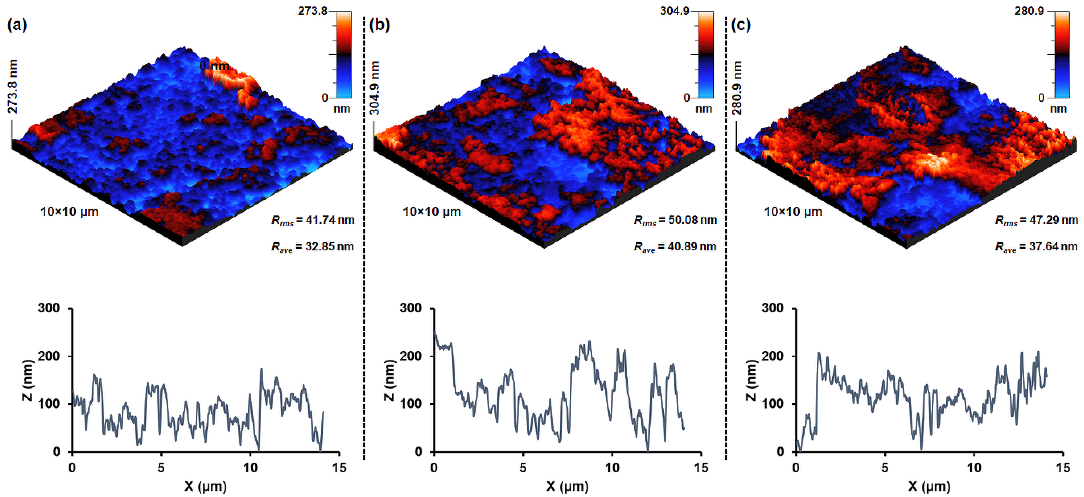
Figure 5. Three-dimensional micrographs and surface profiles showing the surface morphology, roughness, and topography of the sensitive element–ZnFe 2 O 4 nanoparticles annealed at ( a ) 600, ( b ) 800, and ( c ) 1000 °C.